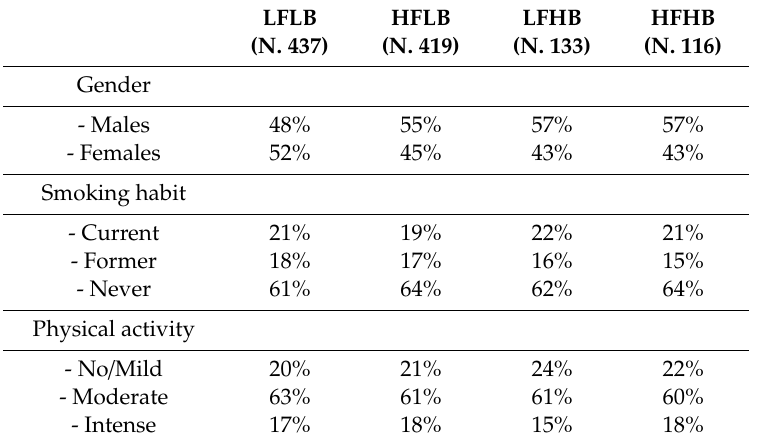
Table 1. Categorical variable distribution in the studied population subgroups.